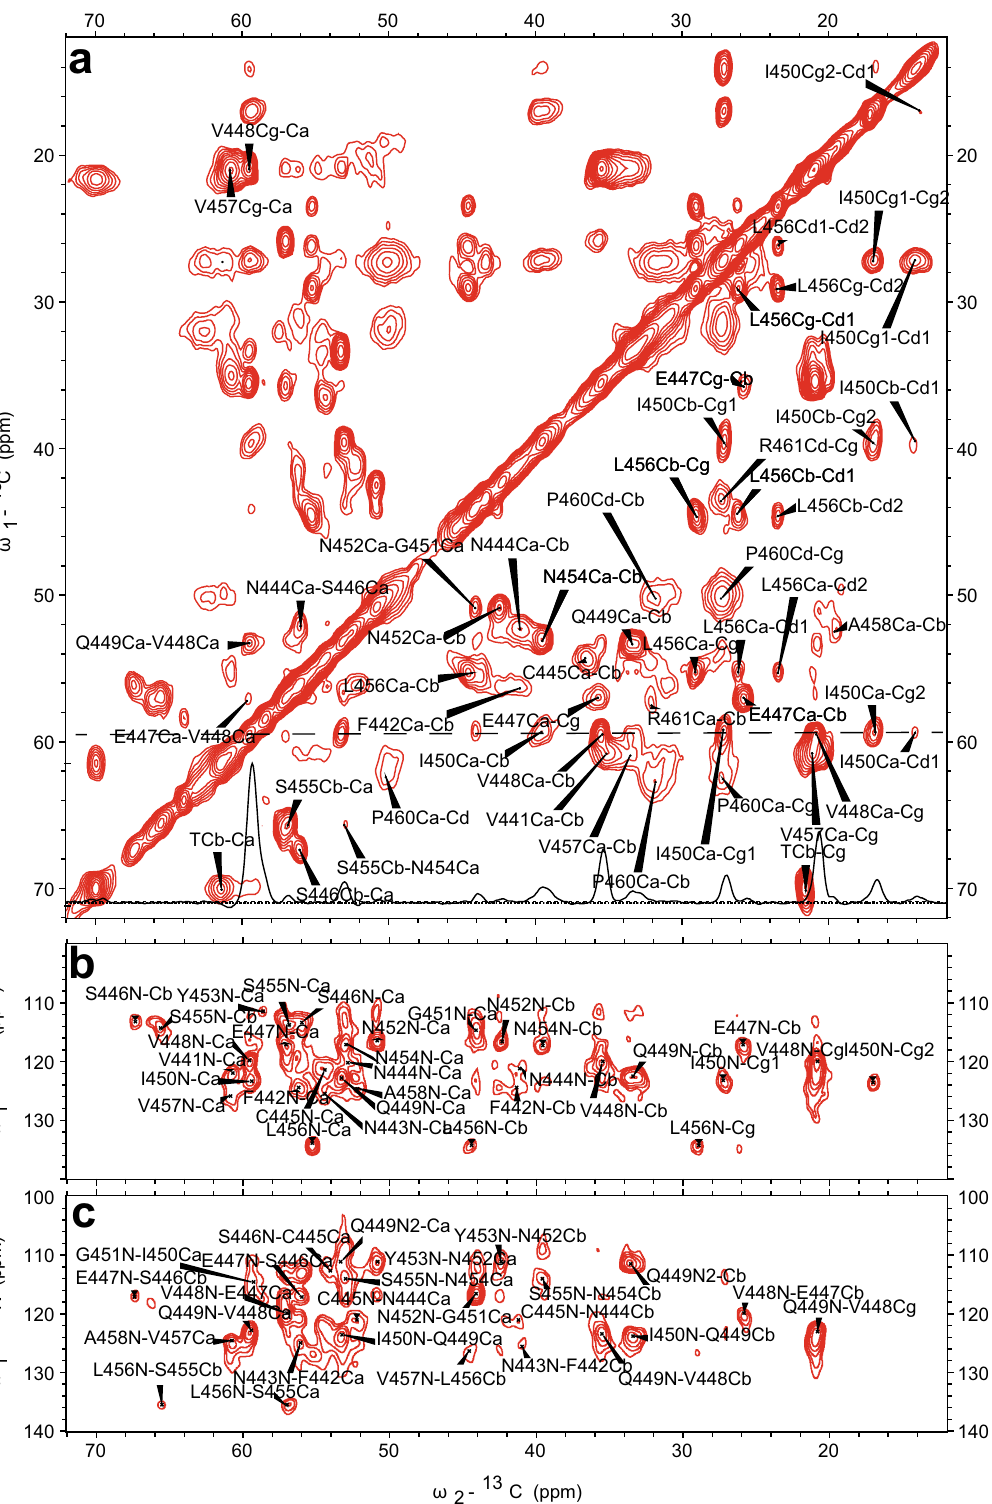
Fig. 3 SSNMR spectra of uniformly labeled mouse RIPK3 fi brils. 2D 13 C – 13 C ( a ), 2D 13 C – 15 N NcaCX ( b ), and 2D 13 C – 15 N NcoCX ( c ) with 50 ms DARR mixing. The experiments were carried on a Bruker 700 MHz MAS NMR spectrometer with ω r = 15 kHz, T = 303 K, and 83.33 kHz 1 H decoupling fi eld applied during